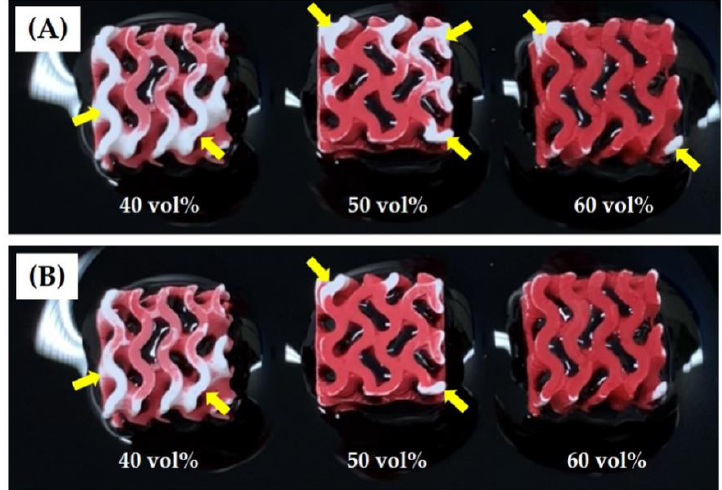
Figure 10. Optical image of the hierarchically porous CaP scaffolds manufactured using a range of camphene-camphor amounts (40 vol %, 50 vol %, and 60 vol %) after various immersion times of ( A ) 10 s and ( B ) 25 s. For clear observation, a red dye was added to the water. Yellow arrows indicate the regions without water